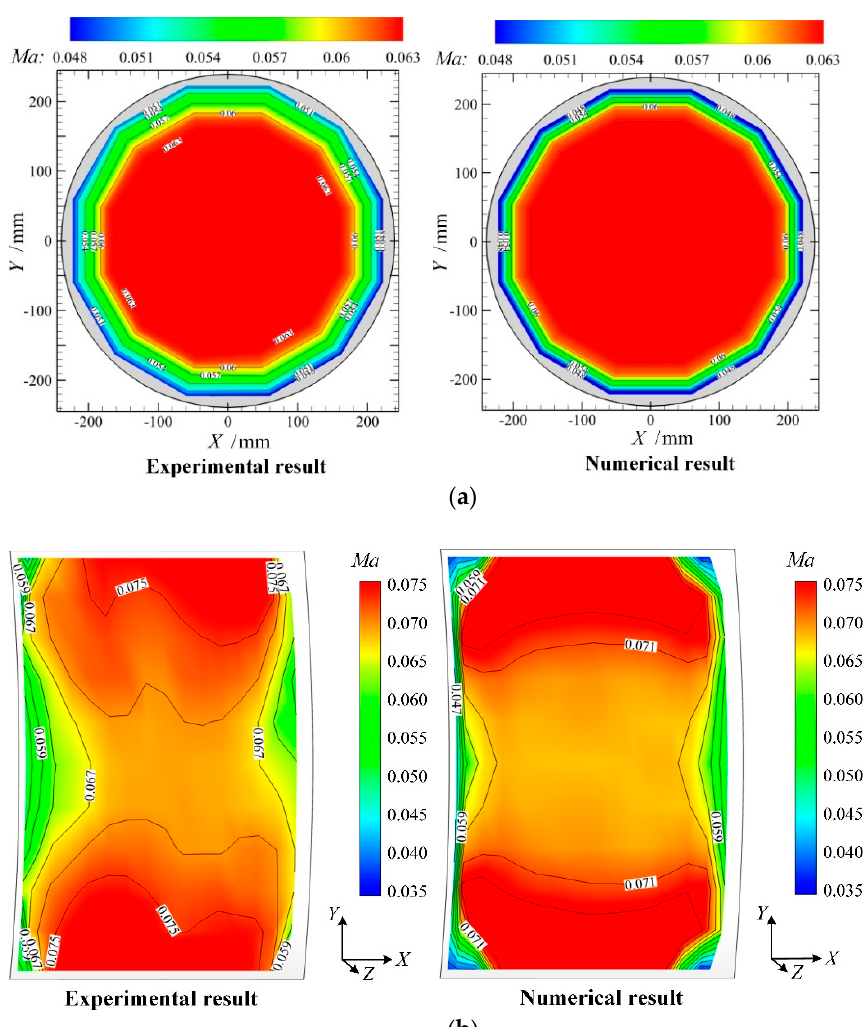
Figure 6. Comparison of the measured and simulated Mach numbers in the radial inlet chamber. ( a ) Results for the inlet section. ( b ) Results for the interface of the intake and spiral channels.